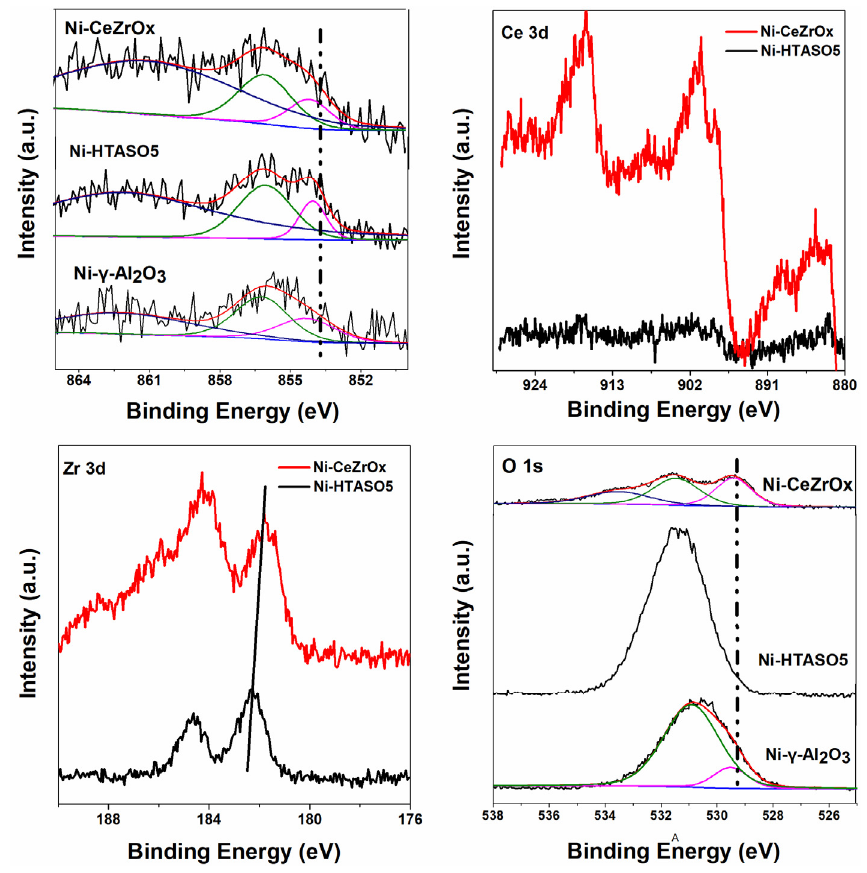
Figure 4. Ni 2p, Ce 3d, Zr 3d and O 1s binding energy of Ni- γ -Al 2 O 3 , Ni-HTASO5 and Ni-CeZrO x catalysts. Table 3. Surface content of different nickel species on reduced catalysts determined by XPS.